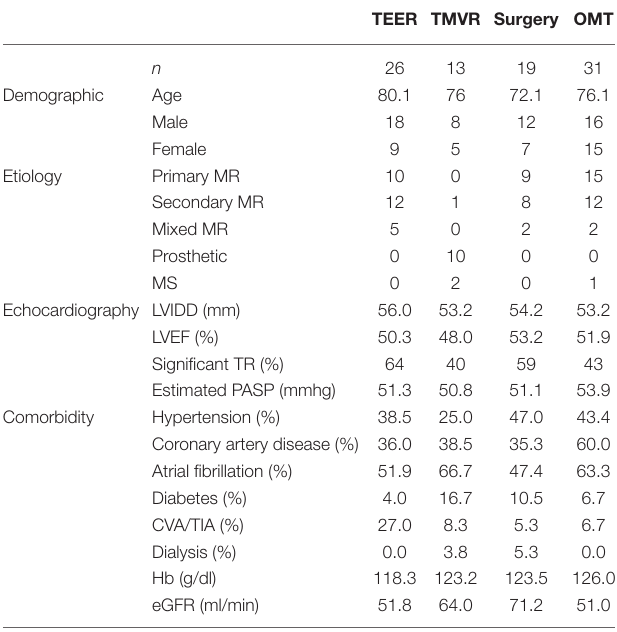
TTE, transthoracic echocardiogram; TEER, transcatheter edge-edge repair; TMVR, transcatheter mitral valve replacement; MR, mitral regurgitation; MS, mitral stenosis; LVIDD,leftventricularinternaldiameterenddiastole;TR,tricuspidregurgitation(significant defined as moderate or greater); PASP, pulmonary artery systolic pressure; CVA, cerebrovascular accident; TIA, transient ischaemic attack; Hb, hemoglobin; eGFR, estimated glomerular filtration rate; OMT, optimum medical